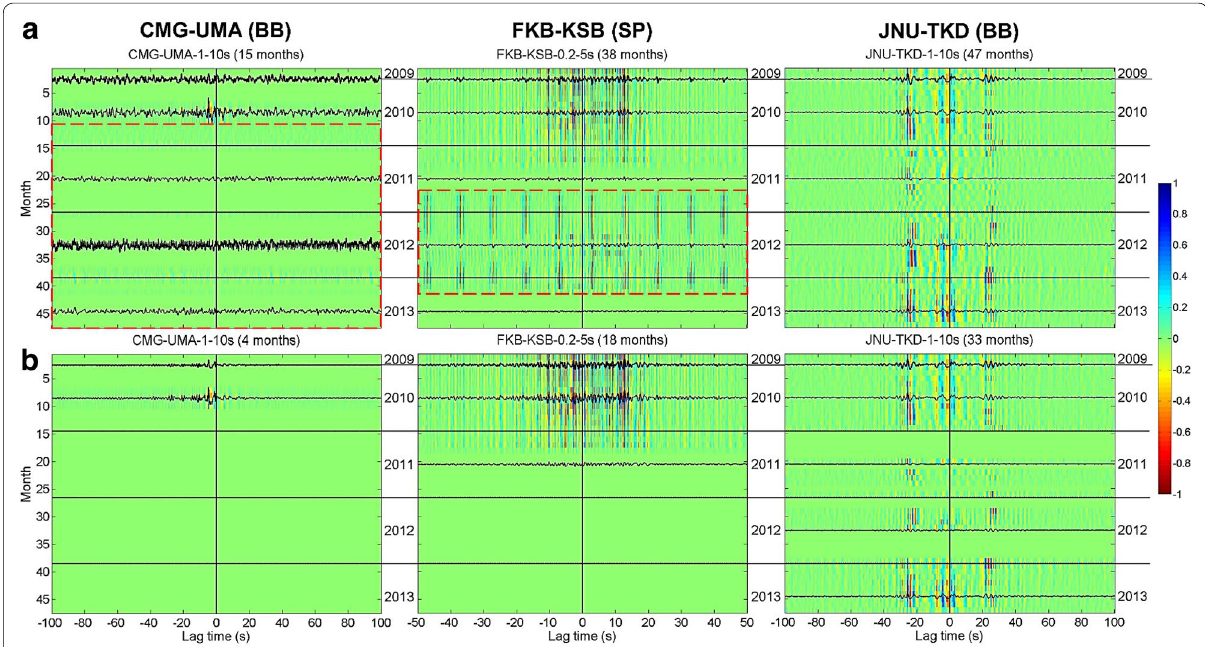
Fig. 4 Examples of problematic monthly CCFs with low SNR (CMG–UMA), periodic signals (FKB–KSB), or temporary time shifts (JNU–TKD) for two BB and one SP station pairs. Monthly CCFs a before and b after eliminating significantly problematic CCFs (inside red dashed boxes). Other illustrations are the same as those presented in Fig.